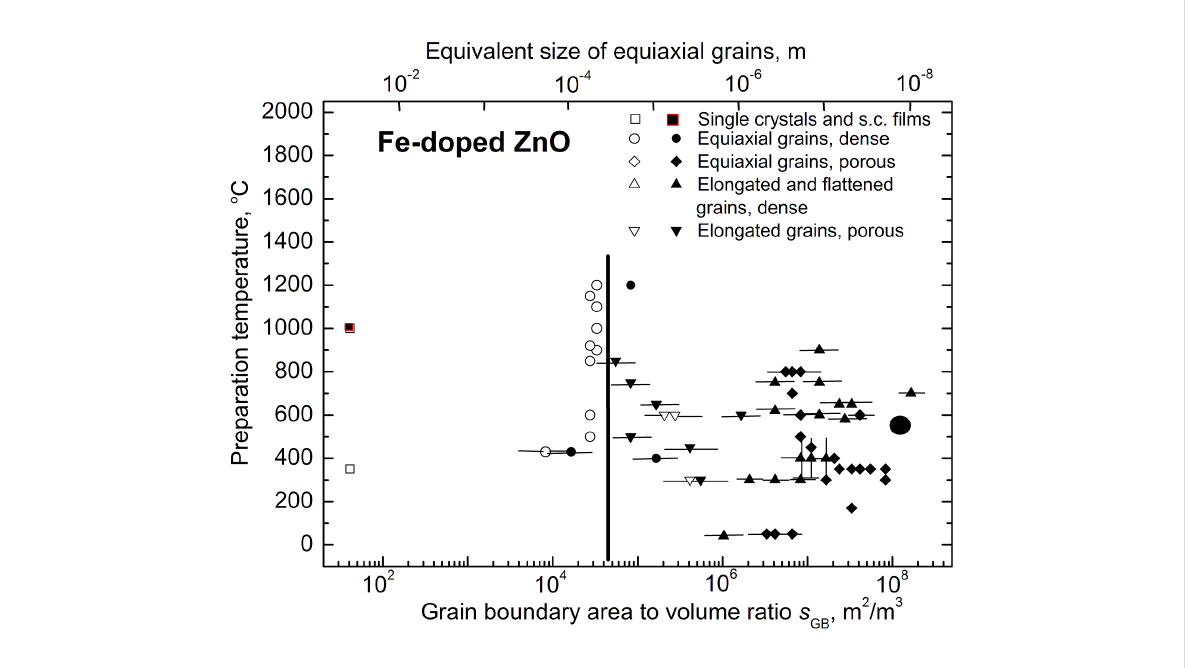
Figure 4: FM (full symbols) and para- or diamagnetic (open symbols) behaviour of Fe-doped ZnO in dependence on the specific GB area, s GB , the ratio of GB area to volume, at different preparation temperatures T . A vertical line marks the estimated threshold value s th . The enlarged symbol indi- cates the experimental data obtained by the authors’ own investigations (for symbols and references see the text).